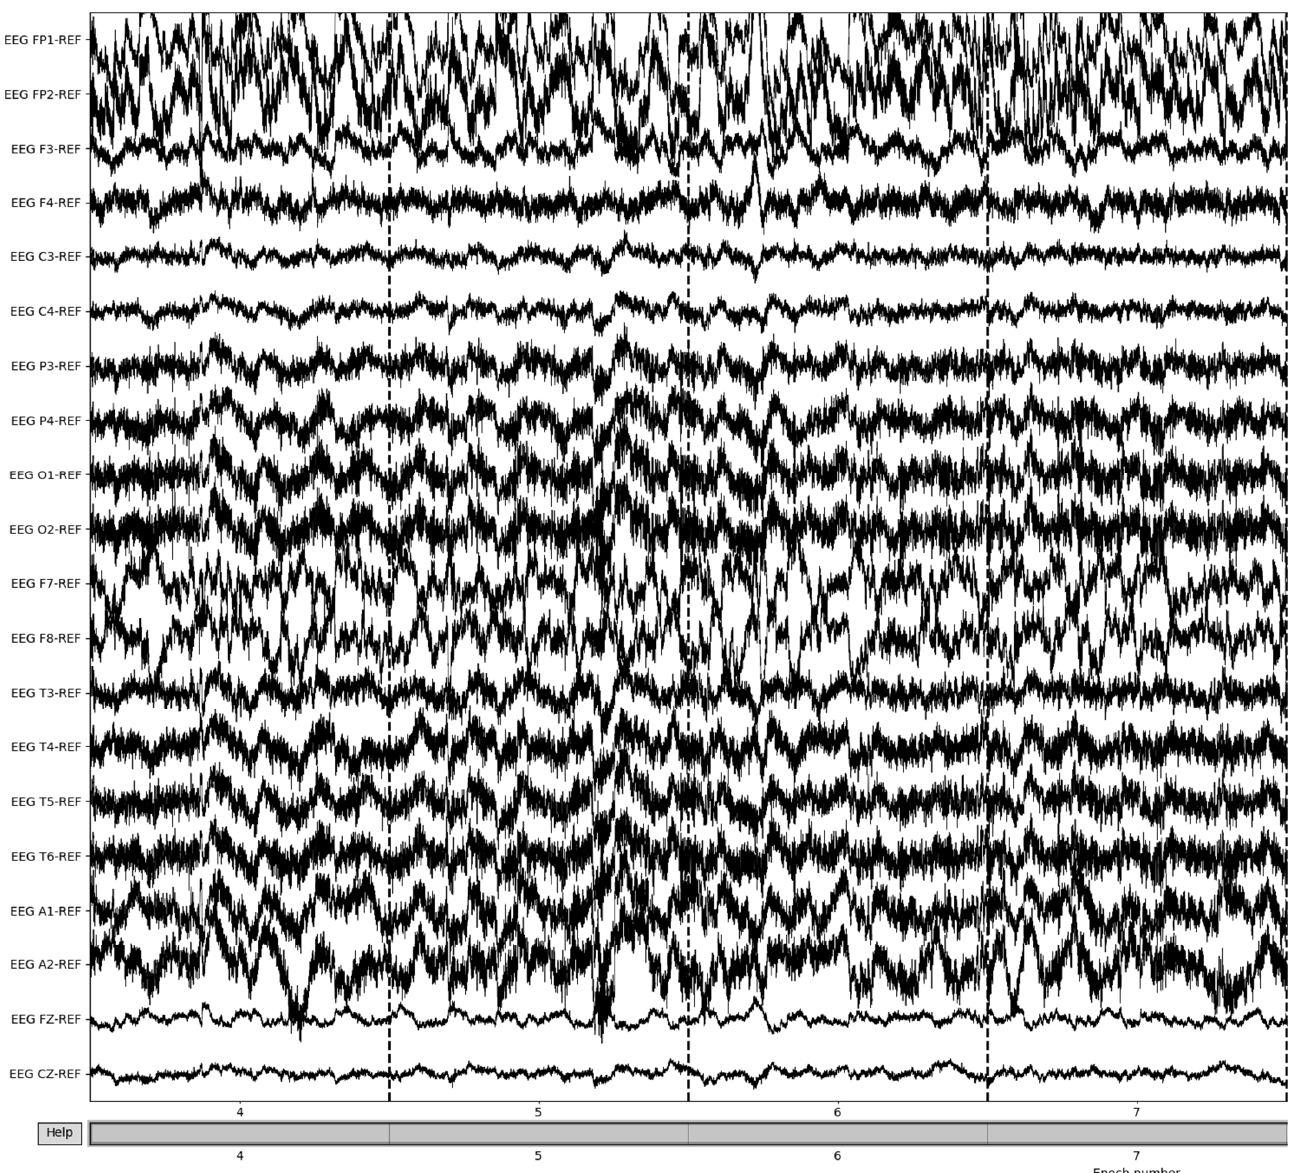
Figure 7. Post-bad epoch removal of EEG recordings.